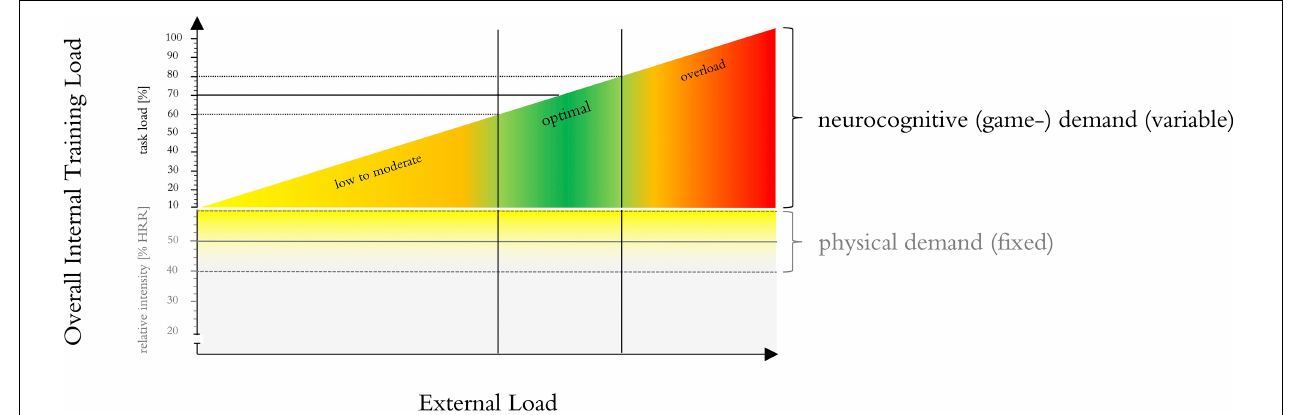
FIGURE 1 | Methodological framework for the contribution of physical- and neurocognitive- (i.e., game-) demands during